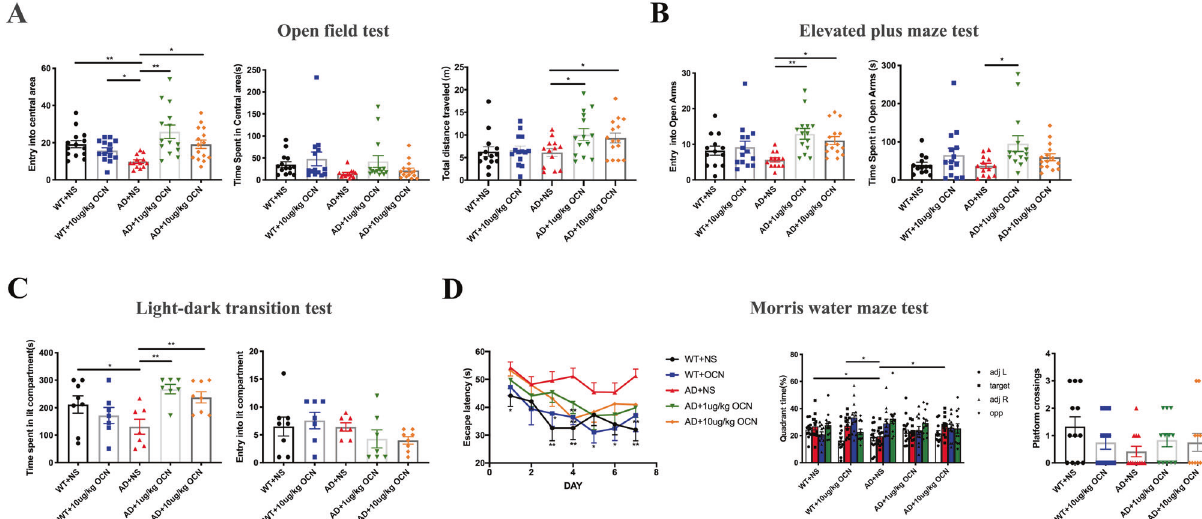
Fig. 1 OCN ameliorated the anxiety-like behaviors and cognitive dysfunctions in APP/PS1 transgenic AD mouse model. In the Open Field Test ( A ), OCN signi fi cantly increased the entries into the central area and total distance traveled in AD mice, especially in 1 μ g/kg OCN group ( n = 13 – 15 per group). In the Elevated Plus Maze Test ( B ), OCN increased the time and entries that AD mice entered into open arms, especially in the 1 μ g/kg OCN group ( n = 13 – 15 per group). In the Light-Dark Transition Test ( C ), OCN signi fi cantly increased the time of AD mice spent in the light chamber ( n = 7 – 8 per group). In the Morris Water Maze Test ( D ), AD mice exhibited increased escape latency during the training stage, which was decreased by OCN treatment. In the probe test, 10 μ g/kg OCN signi fi cantly increased the preference for target quadrant in AD mice ( n = 12 per group). All data represent the means ± SEM. A P -value < 0.05 was considered to be statistically signi fi cant by one-way ANOVA followed by post hoc comparisons using LSD ’ s test or Kruskal – wallis test followed by post hoc comparisons using Dunn ’ s test for multiple groups ’ comparisons. * P < 0.05, ** P <